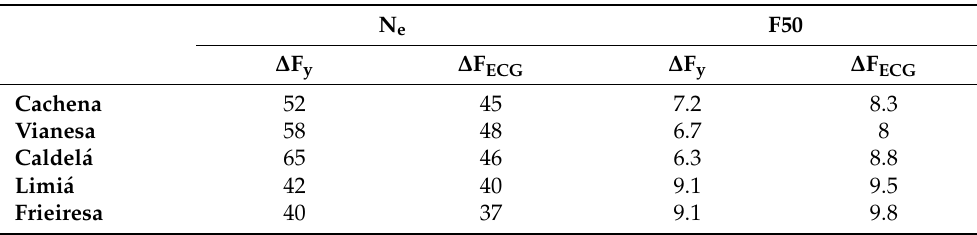
Table 3. Effective population size based on year of birth and on Equivalent Complete Generations of the five Galician bovine breeds.